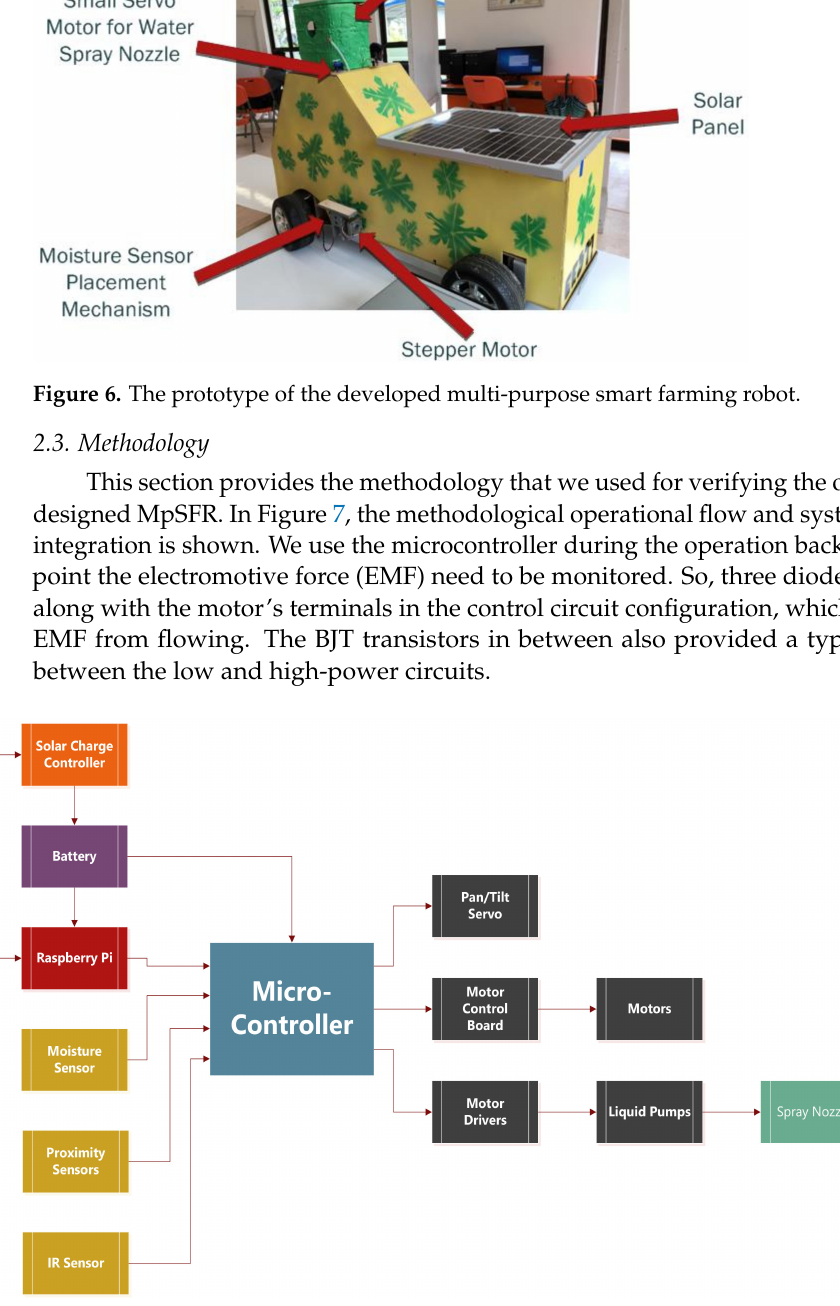
Figure 7. Methodological operational flow and system components integration in the proposed multi-purpose smart farming